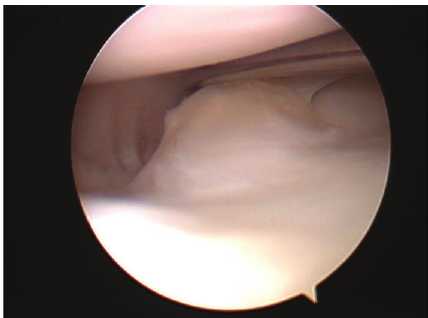
Figure 3: Arthroscopic views of the right knee. Meniscocapsular separation at overlapping middle segment of the double-layered lateral meniscus.